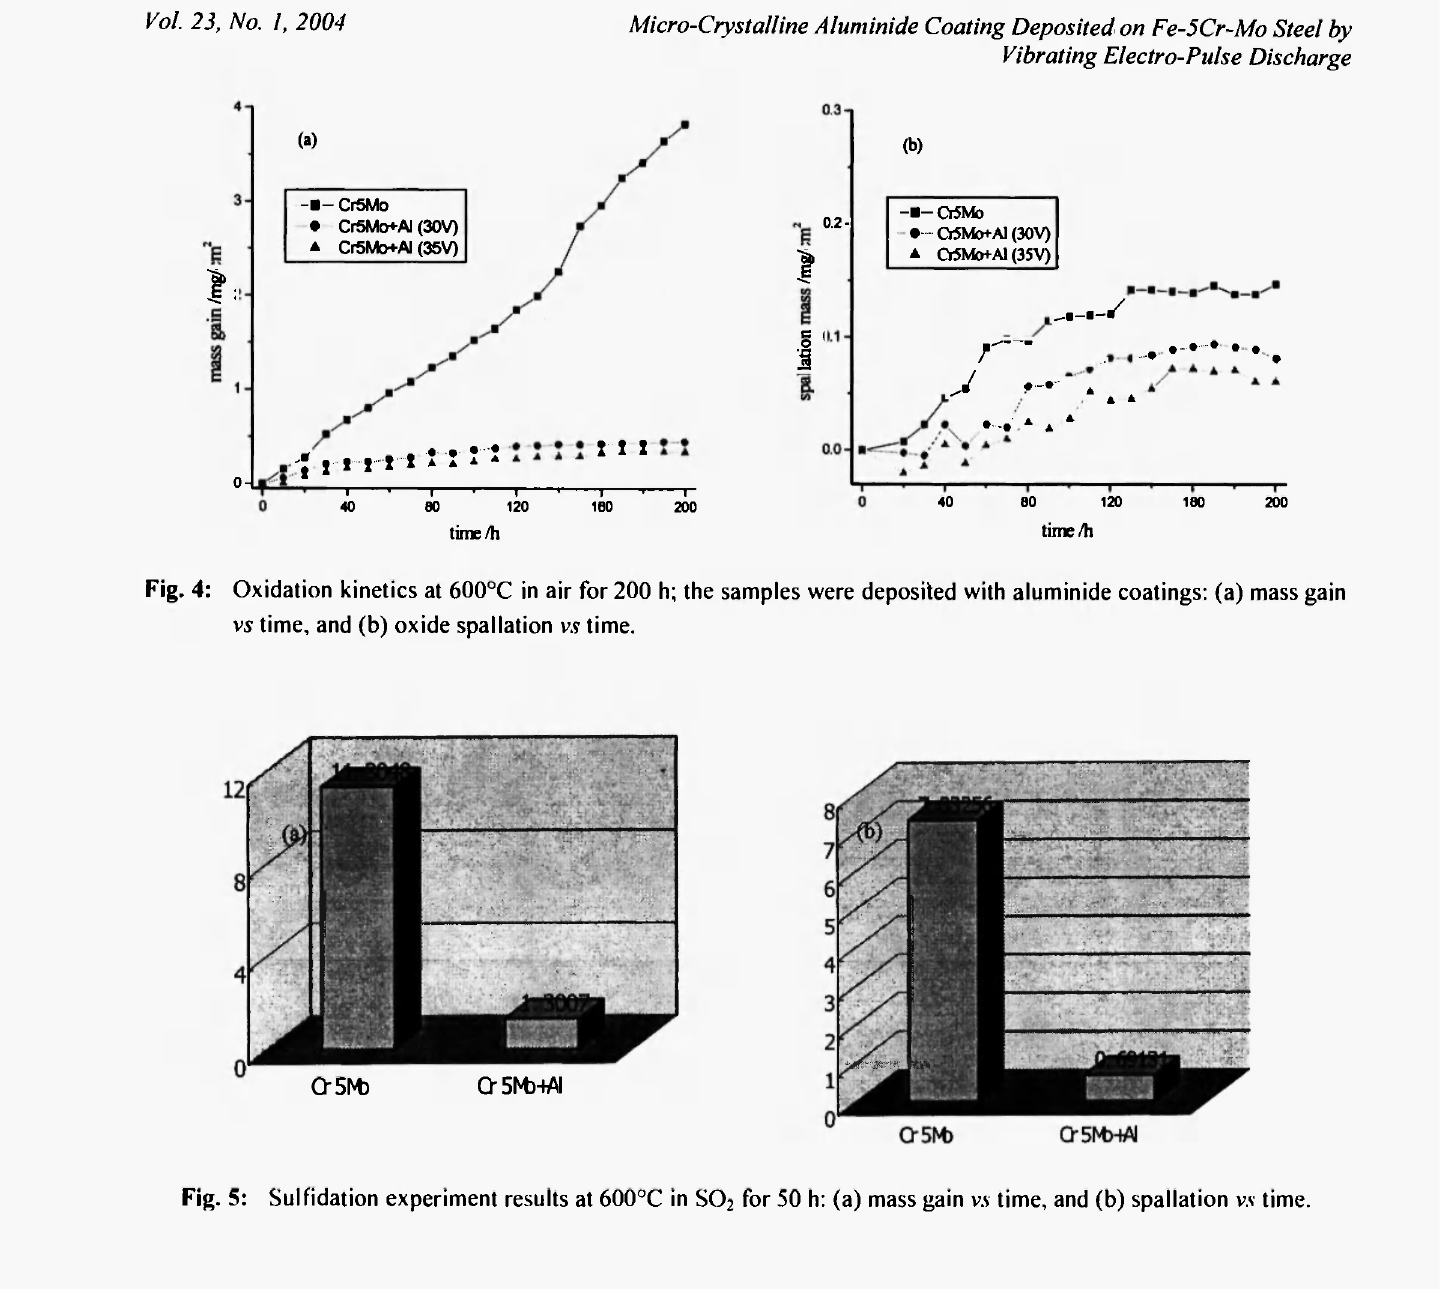
is only about l/IO of the steel. Even the colour of the samples is different: The steel samples showed a brown colour, while the coatings kept a metallic sheen. The sulfidation resistance of the aluminide coatings has also been significantly